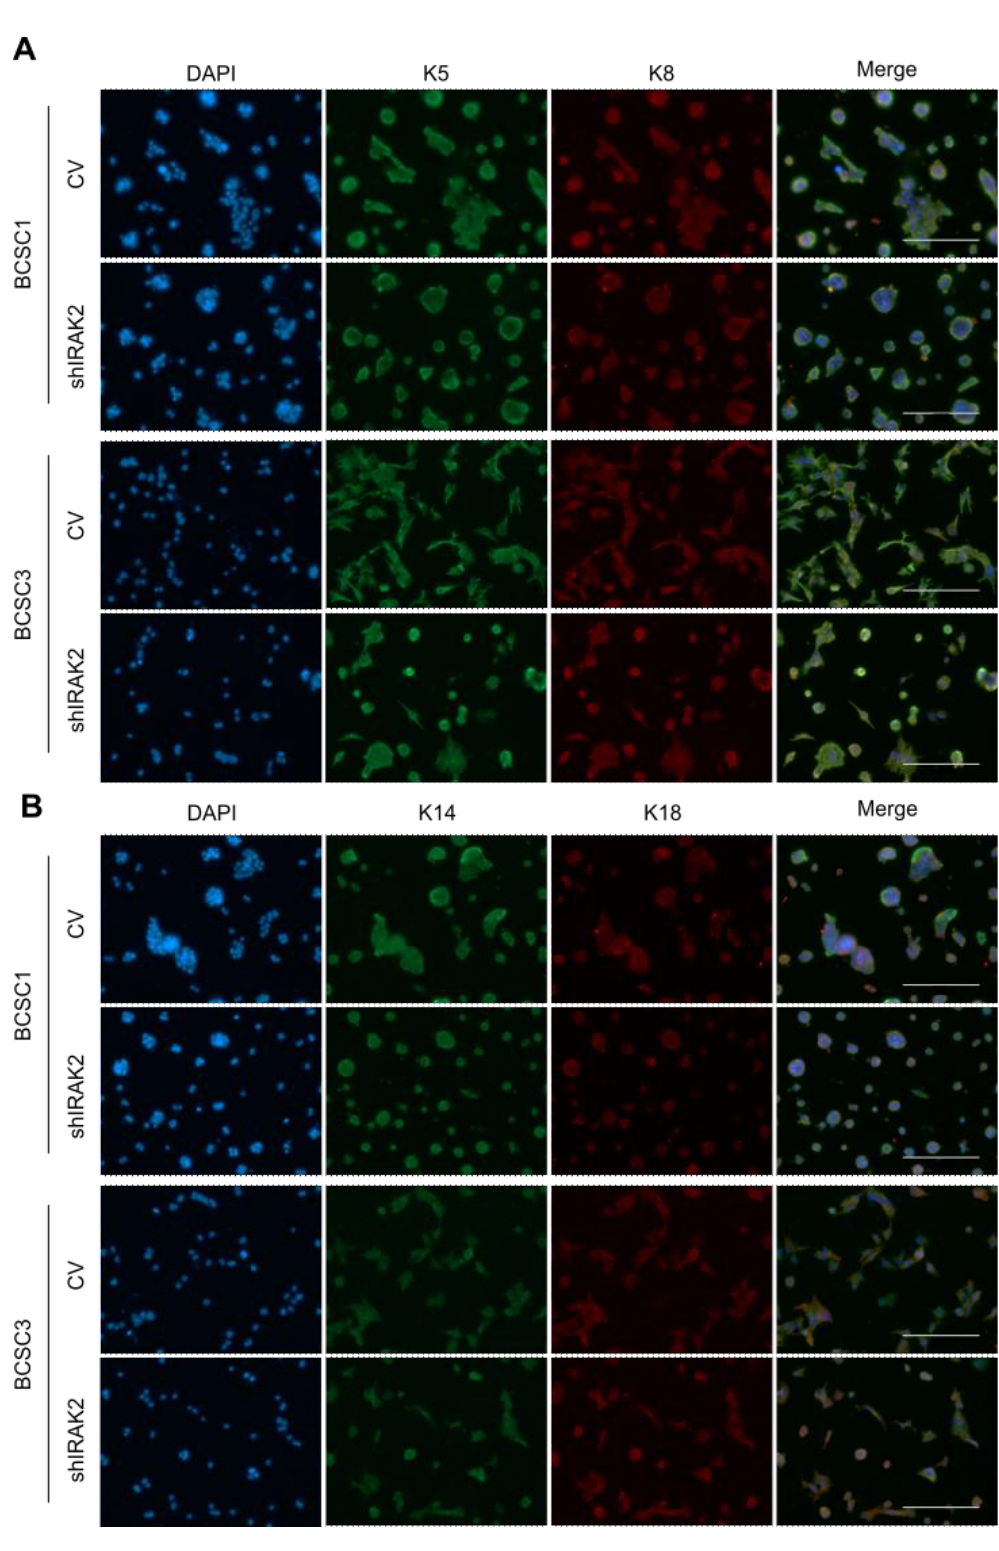
Figure A1. Keratin expression in BCSC1 and BCSC3 is unaffected by IRAK2 knockdown. ( A,B ) Images of immunofluorescence staining of keratins 5 and 8 ( A ), 14 and 18 ( B ) in control (CV) and IRAK2 knockdown (shIRAK2) BCSC1 and BCSC3. Scale bars represent 200 µm.